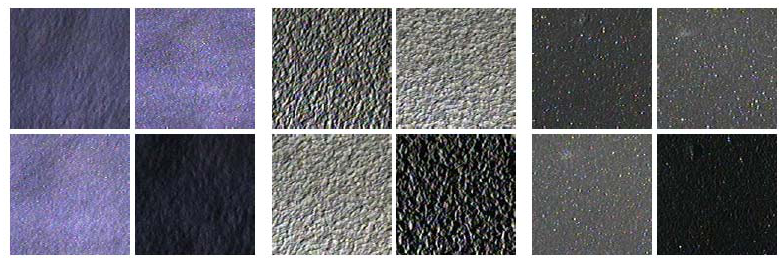
Figure A4. A subset of CURET texture dataset showing 4 examples from each of three classes (from the left group of four to the right: felt, plaster and Styrofoam). Note the large intra-class variability caused by viewpoint and illumination